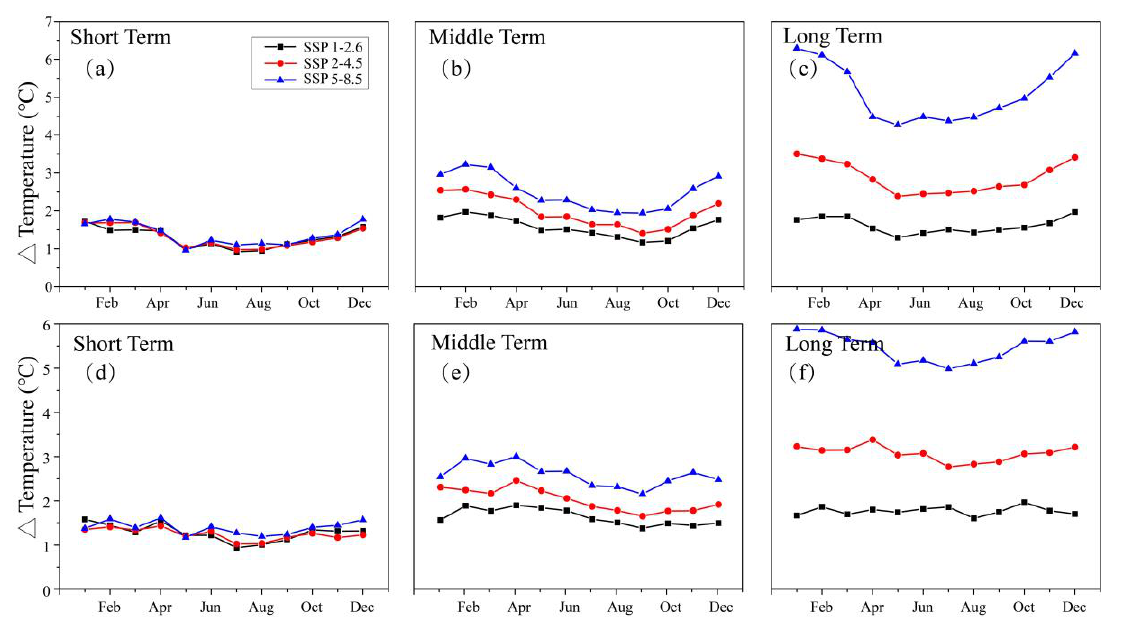
Figure 4. Average maximum (above) and minimum (below) temperature changes over the YZRB for the periods (2020 – 2040, 2040 – 2060, and 2080 – 2100) with respect to the baseline (1979 – 2014) under SSP 1-2.6, SSP 2-4.5, and SSP 5-8.5.